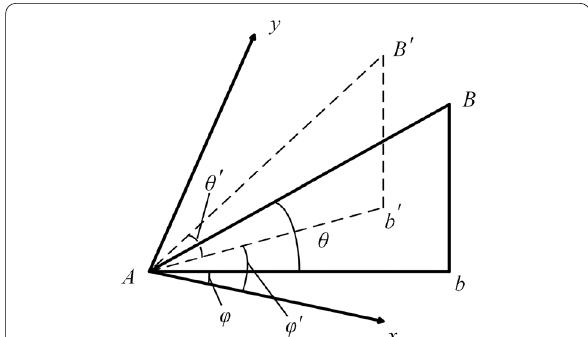
Figure 3 Linear motor direction vector error angle